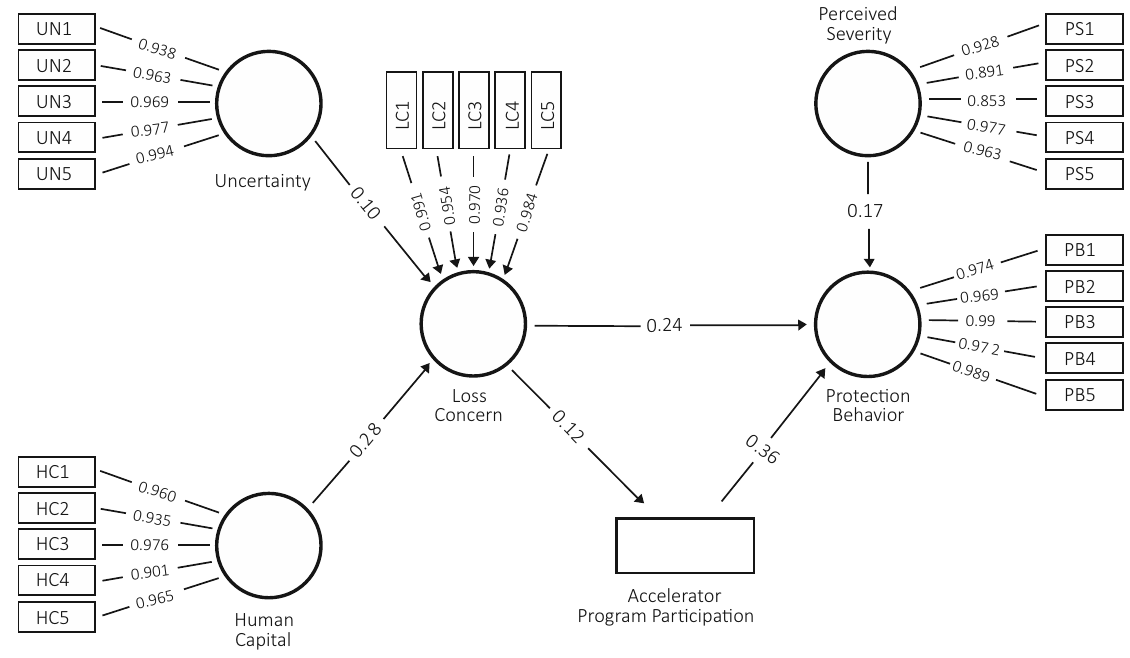
Figure 1. Hypothesized structural